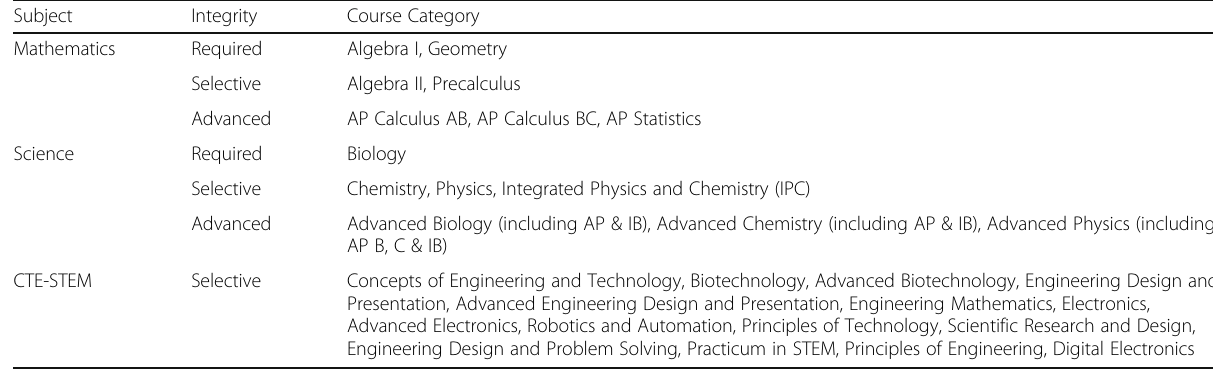
Table 4 High school course category utilized in the